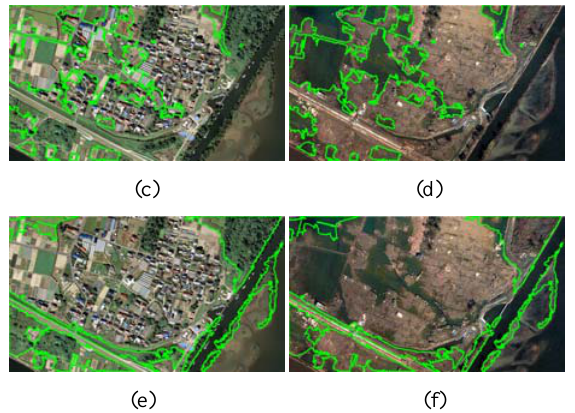
Figure.6 Extraction of Building Damage, Submerged